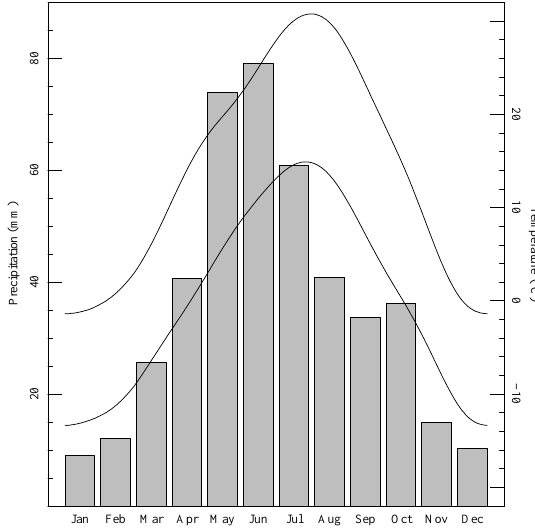
Figure 2. Average of precipitation and temperature for meteorological stations within the study area. Bars show monthly average precipitation, and lines show average minimum and maximum daily temperatures. Data from Arguez et al.